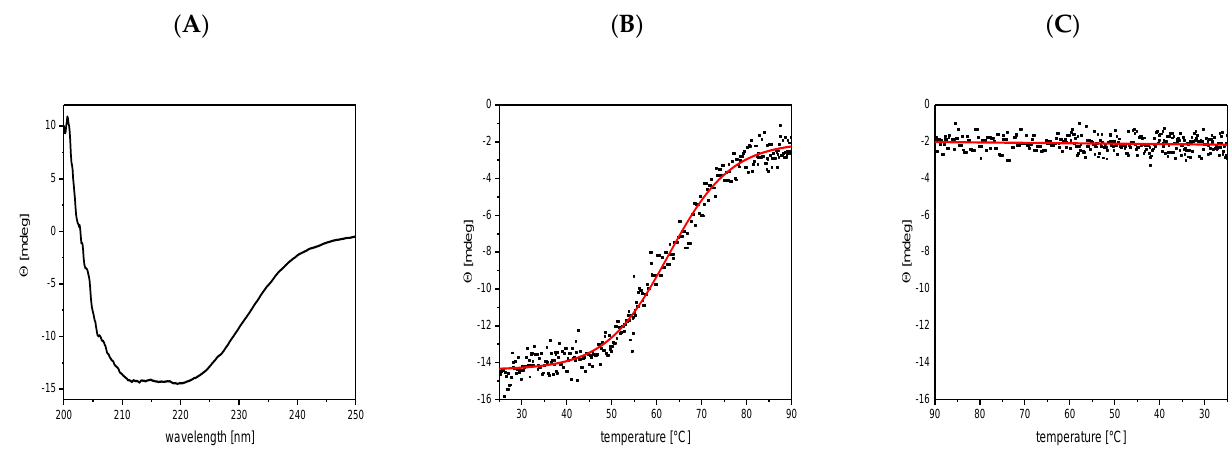
Figure 4. The G1p/G11p contains a high α -helical content and shows thermal stability with a transition point of Tm = 65 ◦ C. ( A ) The purified G1p was analysed for its secondary structure with circular dichroism (CD). ( B ) The unfolding of the α -helical content was followed at 220 nm with increasing temperature, showing a transition point at 65 ◦ C. ( C ) Refolding of the unfolded protein was measured at 220 nm from 90 ◦ C to 25 ◦ C.